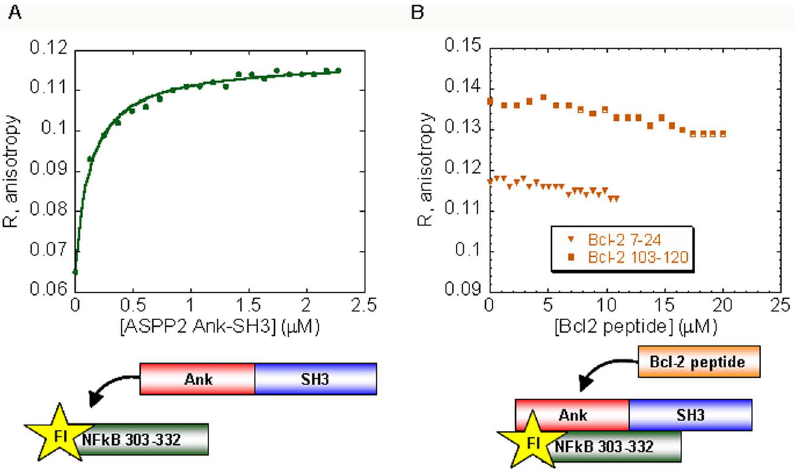
Figure 7. ASPP2 Ank-SH3 binds NF k B 303–332 and is not displaced by Bcl-2 peptides. (A) ASPP2 Ank-SH3 binds Fl-NF k B 303–332 with K d =0.13 6 0.01 m M; (B) Non-labeled Bcl-2 103–120 (orange square) or Bcl-2 7–24 (orange triangle) peptides were titrated into the fully formed complex between Fl-NF k B 303–332 and ASPP2 Ank-SH3 but did not compete with ASPP2 Ank-SH3 on peptide